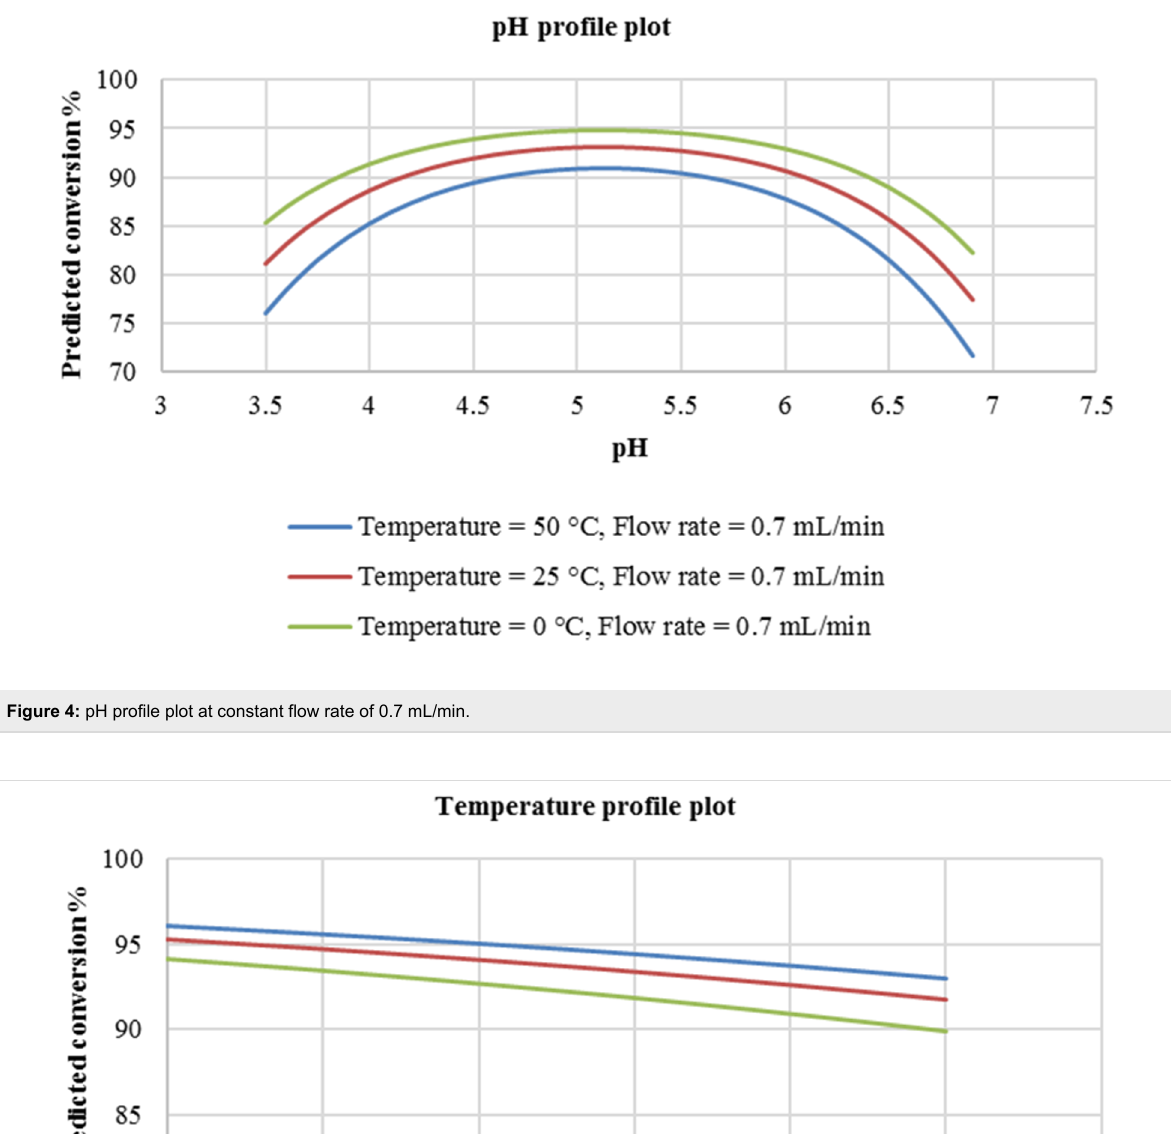
Figure 5: Temperature profile plot at constant pH 5.66.